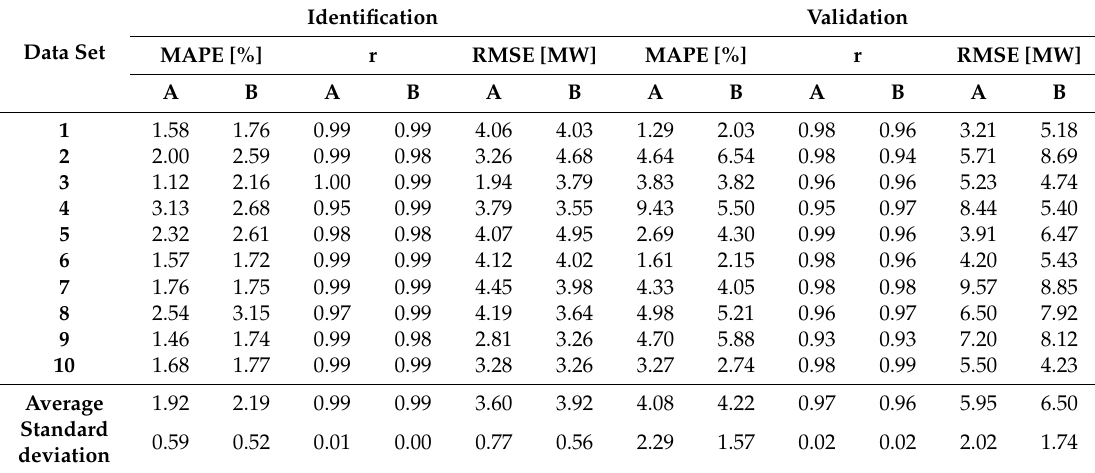
Table 3. Mean absolute percentage error (MAPE), r and root mean squared error (RMSE) for the total heat demand forecast of 4061 buildings with 10 data sets (Table 1). The length of identification data was one week for model A and two weeks for model